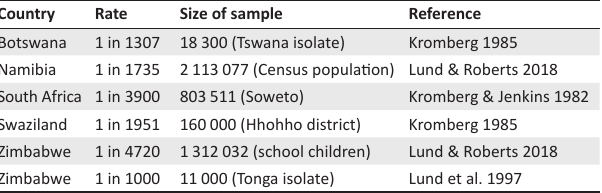
TABLE 1: Prevalence rates of albinism in Southern African countries. Country Rate Size of sample